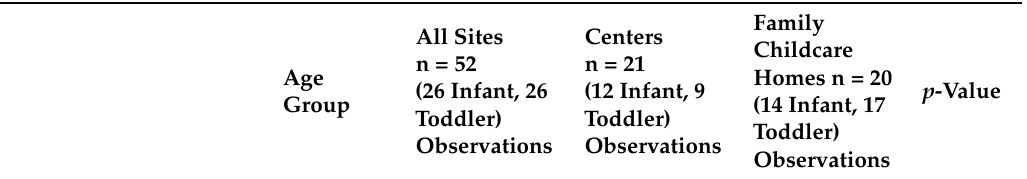
Table 4. Time Spent by Level of Physical Activity and Screen time and Environmental Features Provided Overall and By Site